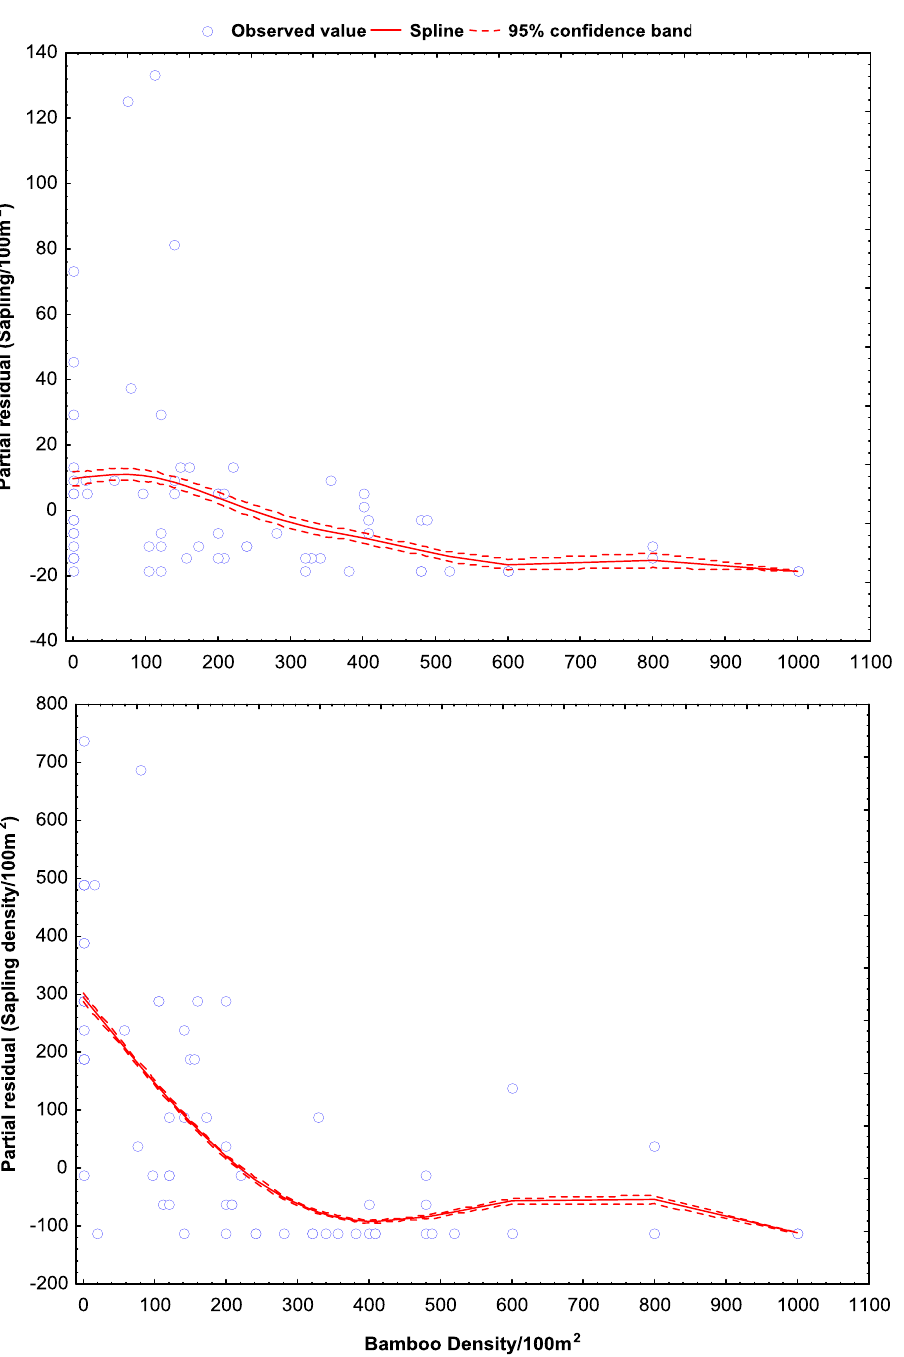
plots, within which 25 m 2 (5 m × 5 m) plots exactly in the middle were selected to study shrubs, bamboos, and tree saplings. We laid two quadrats m 2 (1 m × 1 m) each in the alternative corners of the major plot to study tree seedlings and other herbaceous species. We considered mature trees having the girth size ≥ 30 cm (girth at breast height; 1.3 cm above the ground level); the saplings having girth of < 30 cm to ≥ 10 cm, while we regarded seedlings having collar girth < 10 cm /or collar diameter < 3.14 cm at the height of 1 cm from the ground level. In all the plots, we recorded total number and the respective diameters of each tree. Measuring tape was used to measure the tree/ sapling circumference, however, seedling diameter was measured with the help of digital